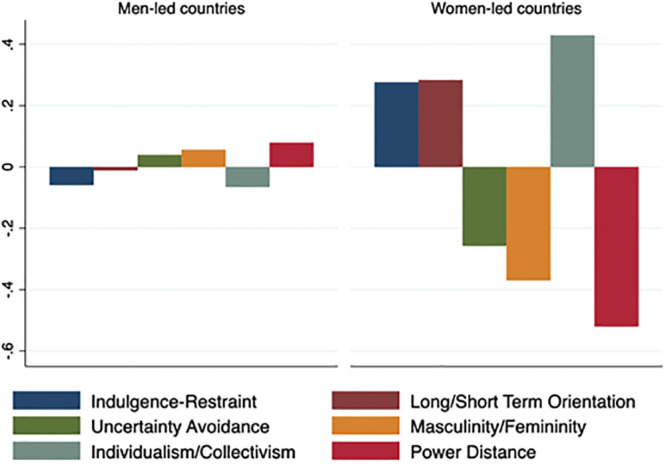
Differences in cultural dimensions between countries led by men and women, using Hofstede [10, 11] cultural data and authors’ definition of leadership gender.N = 175; nwomen-led = 16; nmen-led = 159.